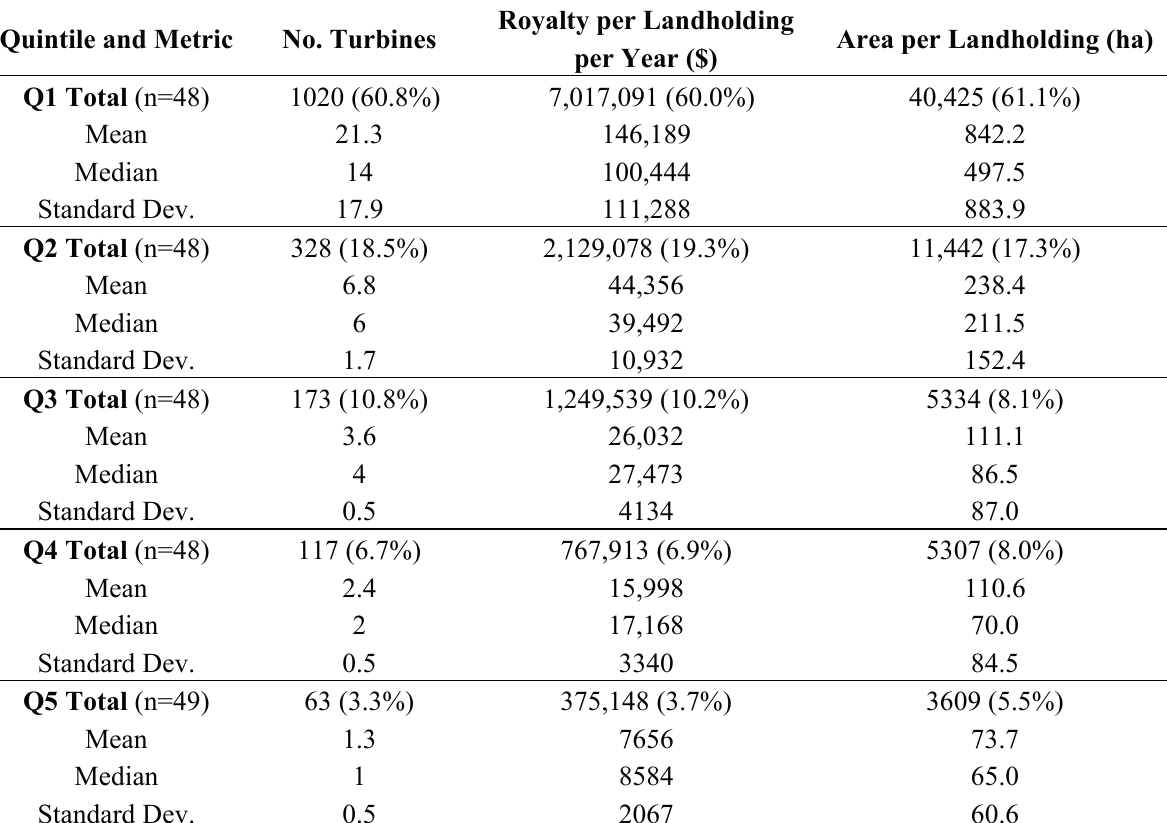
Table 3. Landholdings with turbines divided into quintiles for number of turbines and estimated royalty per landholding per year.